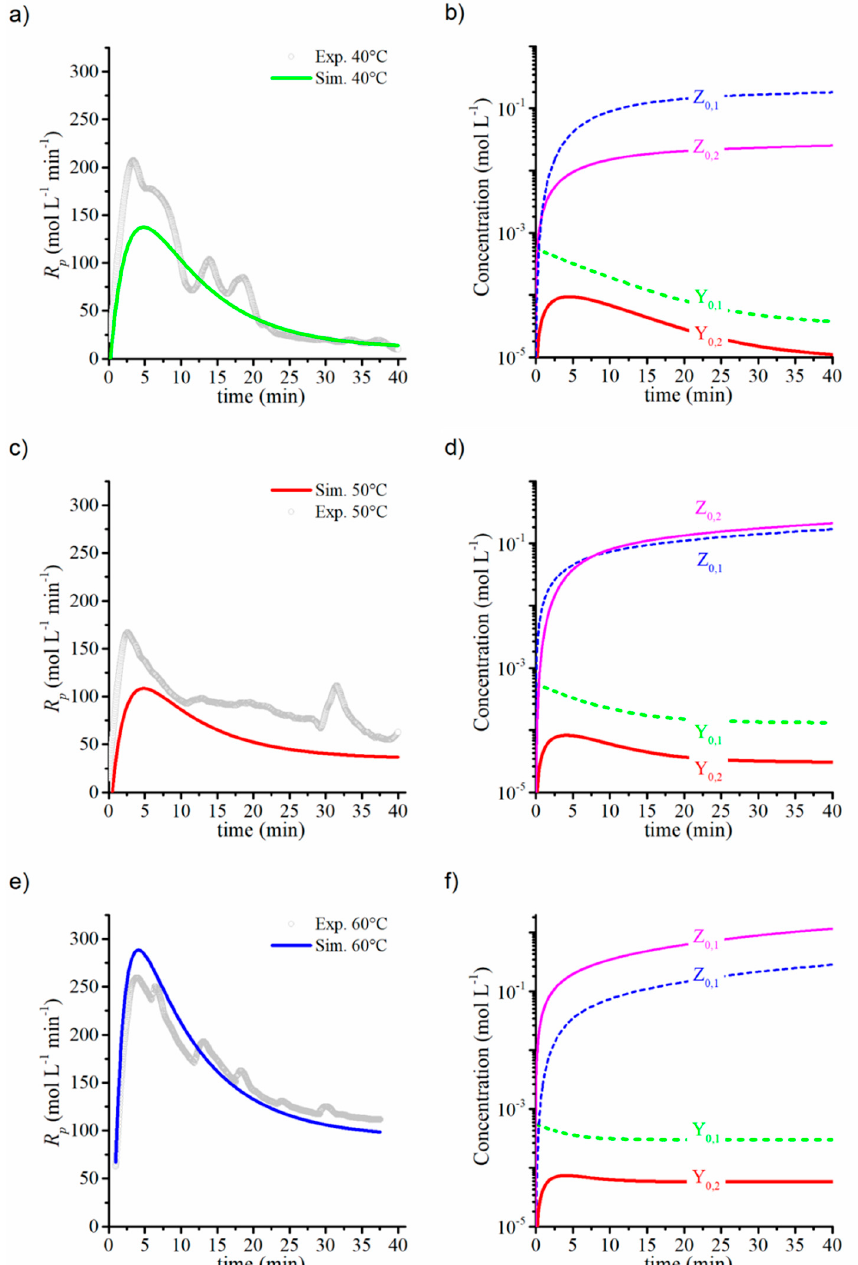
Figure 7. Effect of the temperature variation at 40 ◦ C ( a , b ), 50 ◦ C ( c , d ), and 60 ◦ C ( e , f ) on: R p profiles ( a , c , e ) with the experimental data (gray symbols) and the simulation (continues lines), and total concentration of polymer species (zeroth moment) ( b , d , f ). The ratio of [B] 0 /[Zr] 0 = 2.5 and P = 150 bar. Other operating conditions are shown in Table 6.